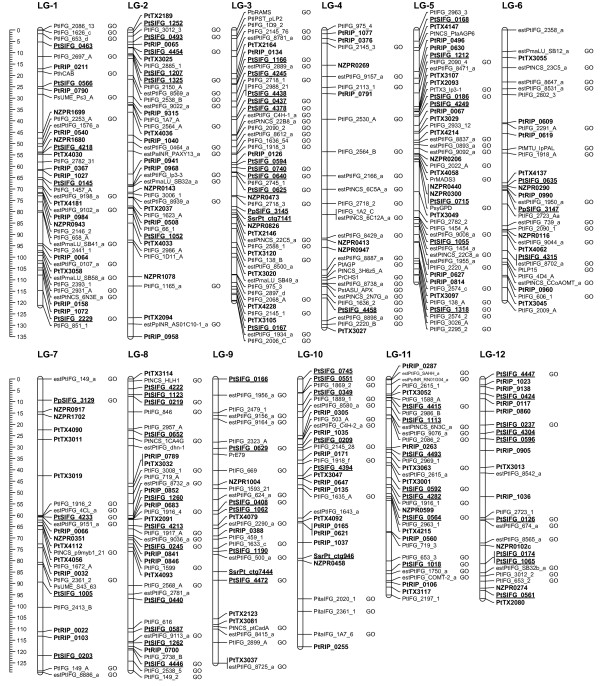
A genetic map of Pinus taeda. The round-2 map of 429 marker loci constructed from the base and qtl pedigrees. The scales to the left are in cM units, marker names in bold font denote genomic-SSR loci, bold underline denotes EST-SSR loci, and plain font denotes ESTP and RFLP loci. A "GO" tag to the right of a locus denotes assignment of a functional Gene Ontology term. Supporting data are in Additional files 2, 5, 8